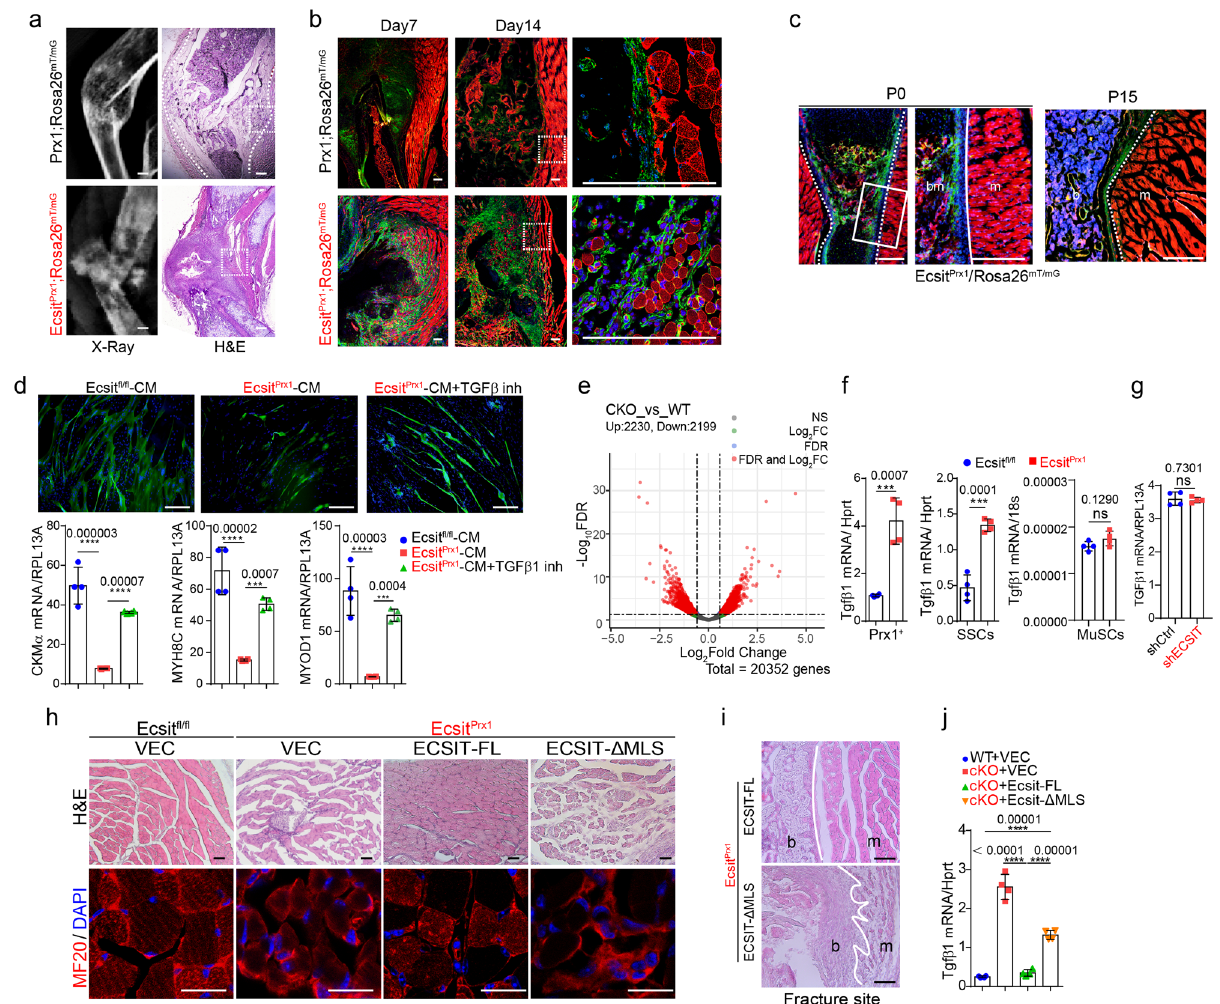
Fig. 6 | Ecsit Prx1 skeletal progenitors induce skeletal muscle